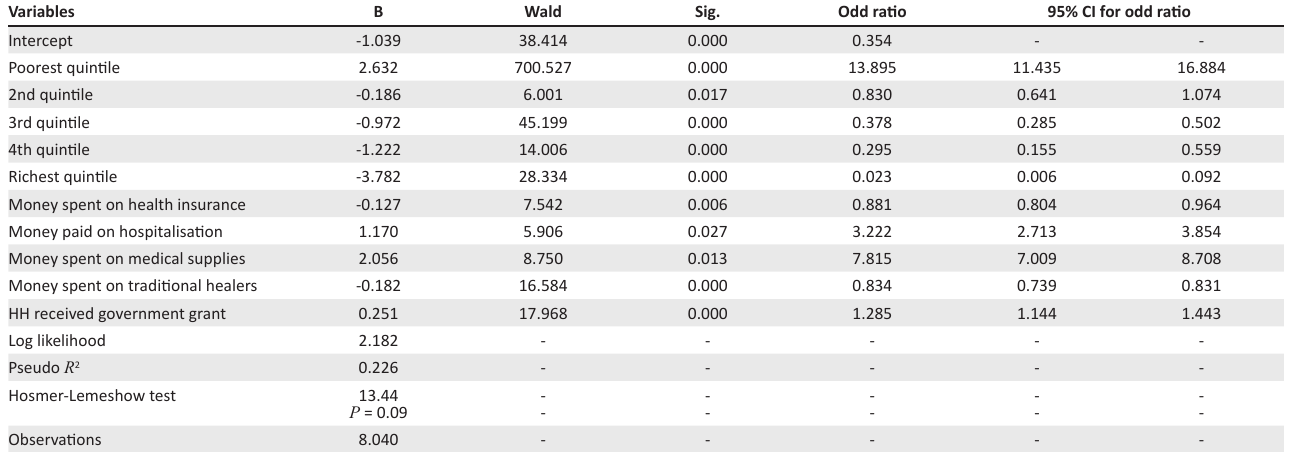
Table 4: Estimated coefficients in logit model for (catastrophic health care expenditure = 1) household-level data. Variables B Wald Sig.